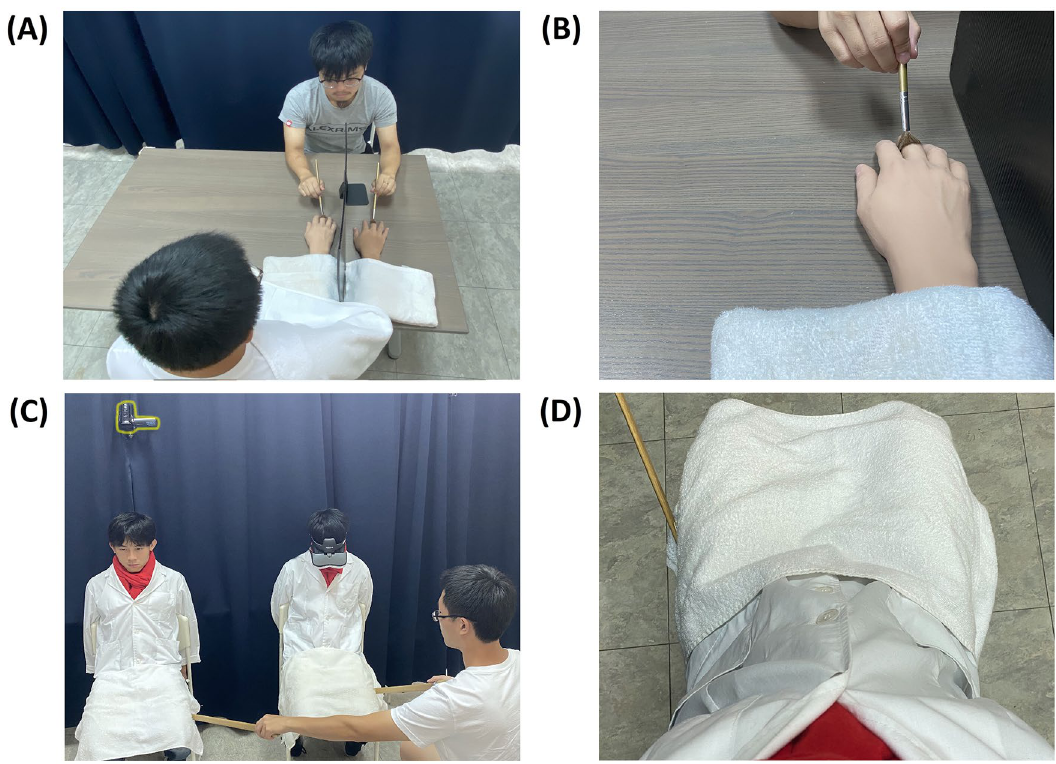
Figure 1. The Experimental Settings. ( A ) The setting of Experiments 1, 3, 5, and 6. The participant placed his/her right hand on a desk and the hand was blocked from view. Instead, he/she saw a rubber hand in front. During the experiment, the participant’s real hand was brushed synchronously or asynchronously with respect to the rubber hand. ( B ) Image seen from the participants’ 1PP in Experiments 1, 3, 5, and 6. ( C ) The setting of Experiments 2 and 4. The participant wore a lab coat, sat on a chair and put on an HMD connected to a real- time camera filming an experimenter’s body. What the participant saw from the adopted 1PP was actually the experimenter’s body. During the experiment, a second experimenter tapped both the first experimenter’s and the participant’s left leg synchronously or asynchronously. ( D ) Image seen from the participants’ adopted 1PP in Experiments 2 and